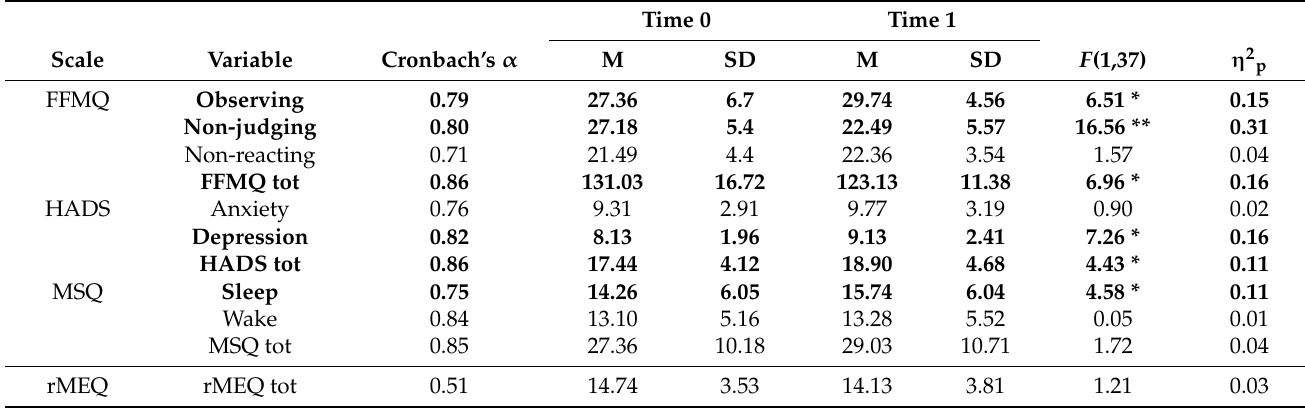
Table 1. Reliability, means, standard deviations, and one-way ANCOVA statistics for variables measured before (Time 0) and during (Time 1)